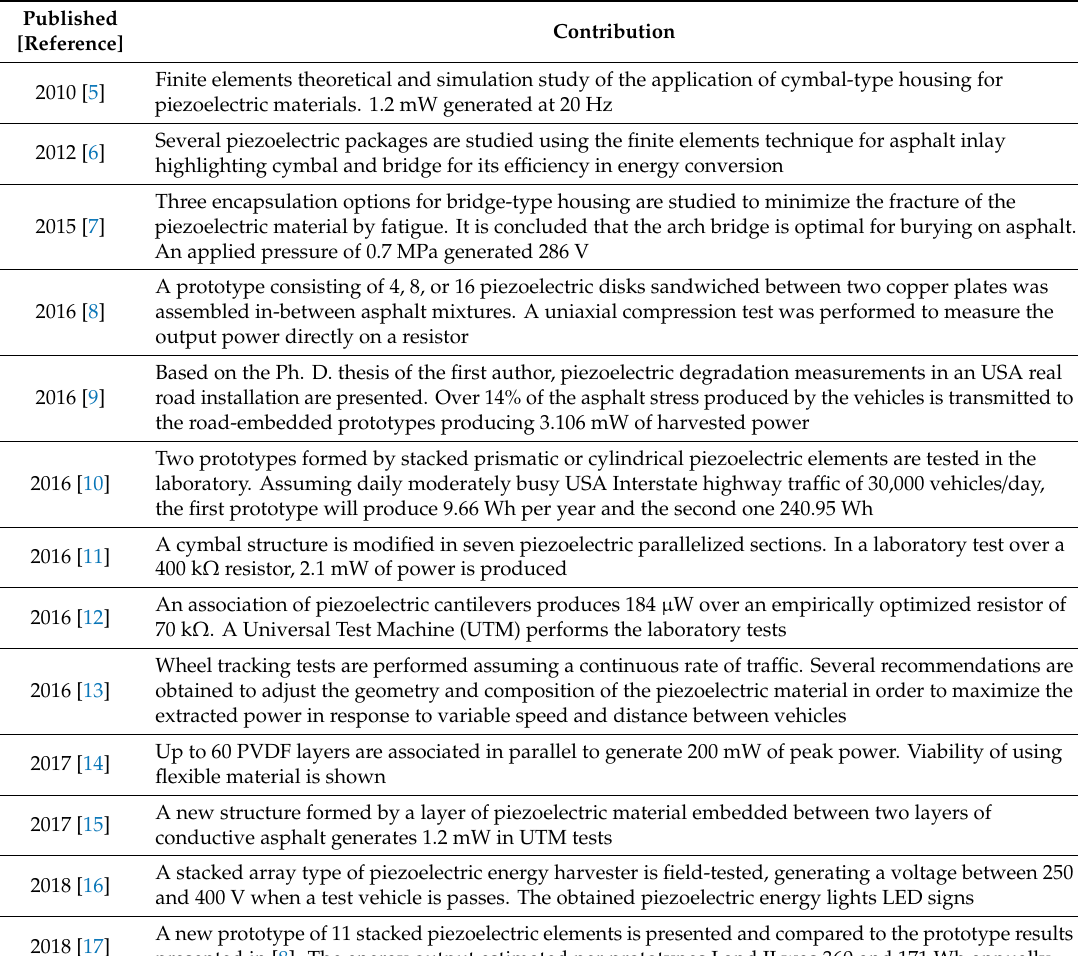
Table 1. Summary of road tra ffi c energy harvesting publications. Review from